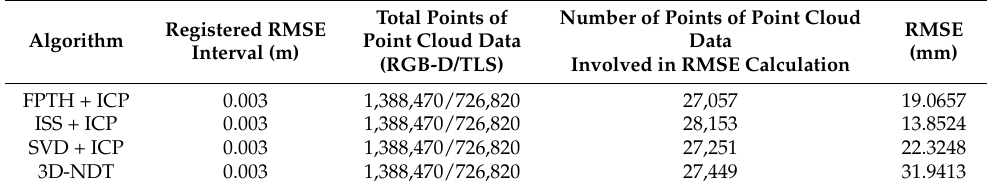
Table 1. Comparison table of repair accuracy by different registration